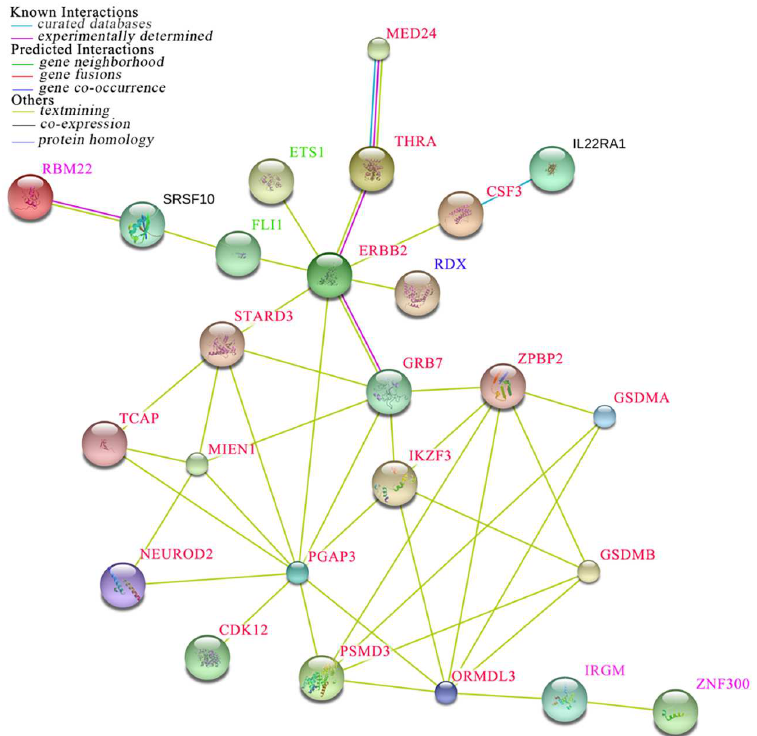
Fig 4. Protein–protein interaction network of the genes at the loci of the 5 SNPs for the top CGCP. Text in red, pink, blue, green and black represents genesat the loci of the 5 SNPs rs10852936,rs2233278, rs4561177, rs6590334and rs7552167, respectively.